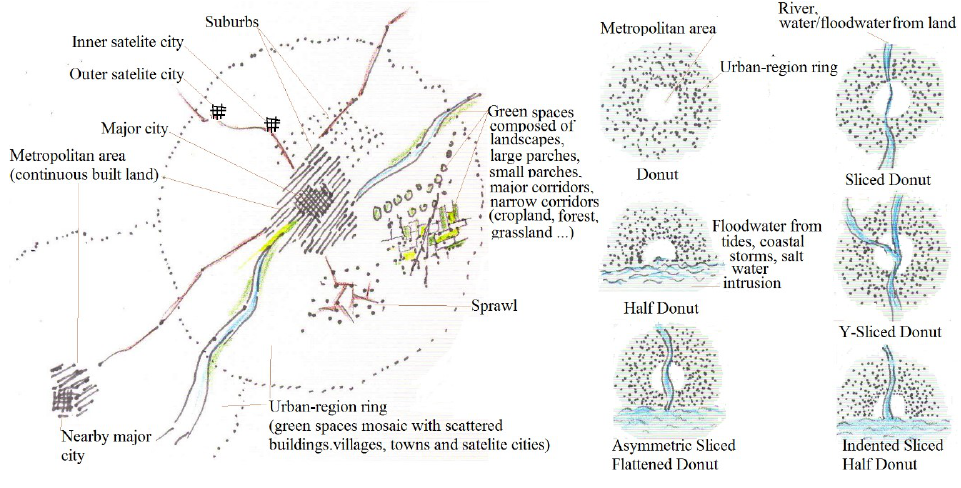
Figure 11: Left: Concepts and terms for urban-regions; Right: Donut